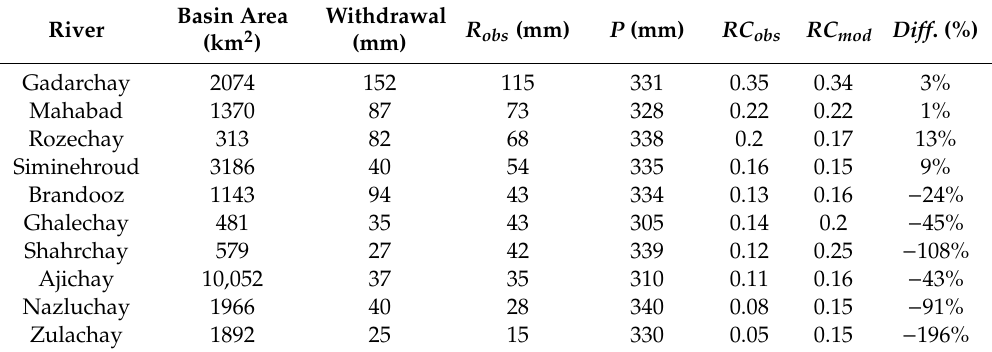
Figure 6. Mean of annual direct RC map in Lake Urmia basin from 2006–2007 to 2010–2011 produced by calibrated Kennessey. Table 7. Gauge river discharge values used in validation of the calibrated Kennessey